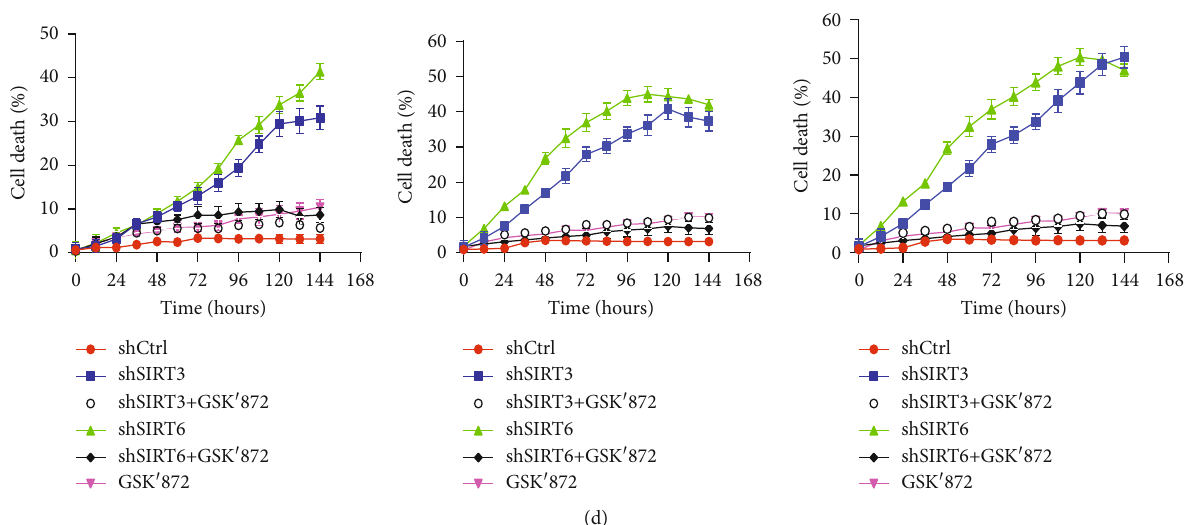
Figure 3: RIPK3-induced necroptosis is mediated by SIRT3 and SIRT6. (a) LNCaP cells stabilized expressed shSIRT3 and shSIRT6 with recombinant GFP and were treated with TNF (20 ng/ml). Cell death was tracked by staining with cytotoxic red and monitored by Incucyte. (b) Cell death curve of LNCaP, PC3, and DU145 cells after induction of control, SIRT1, SIRT3, or SIRT6 shRNA expression with doxycycline. (c) Western blot analysis of p-RIPK3 and p-MLKL protein levels in LNCaP and PC3 cells treated with 20ng/ml TNF. (d) Cell death curve of LNCaP cells treated by RIPK3 inhibitor GSK ′ 872 after induction of control, SIRT3, or SIRT6 shRNA expression with